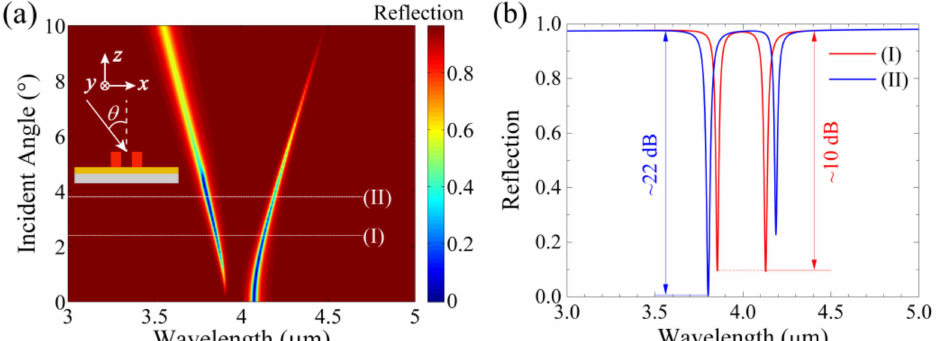
Figure 5. ( a ) Reflection as a function of the incident angle. Inset shows the incident plane, and θ is the incident angle. The horizontal dashed lines marked by (I) and (II) are corresponding to incident angles of 2.4 degrees and 3.8 degrees, respectively. ( b ) Reflection spectra associated with the two cases (I) and (II) in ( a ).